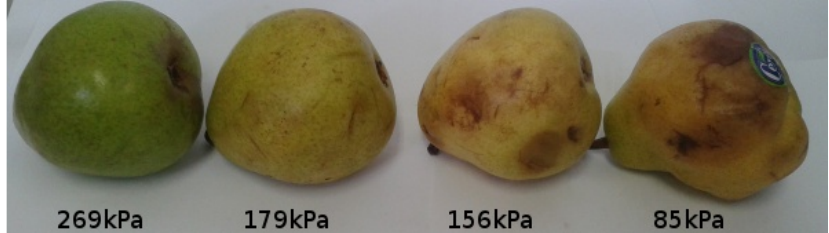
Figure 11. Turgor pressure in Kilo-Pascal (kPa) measured with the glove for peach. The fruit on the left is more unripe and the one on the right is more ripe.